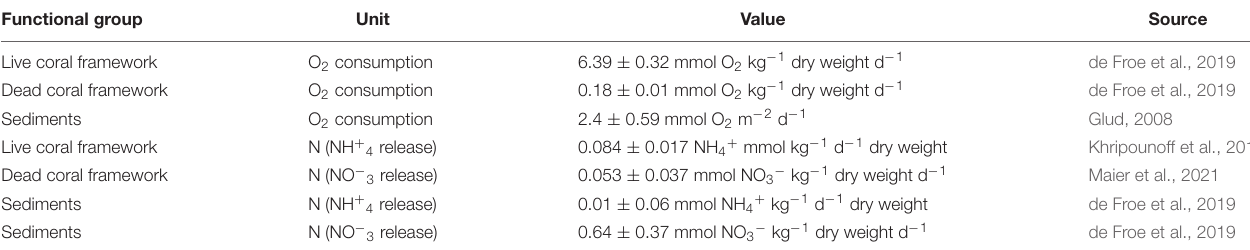
TABLE 2 | Overview of the O 2 consumption and N values used in this study. Functional group Unit Value Live coral